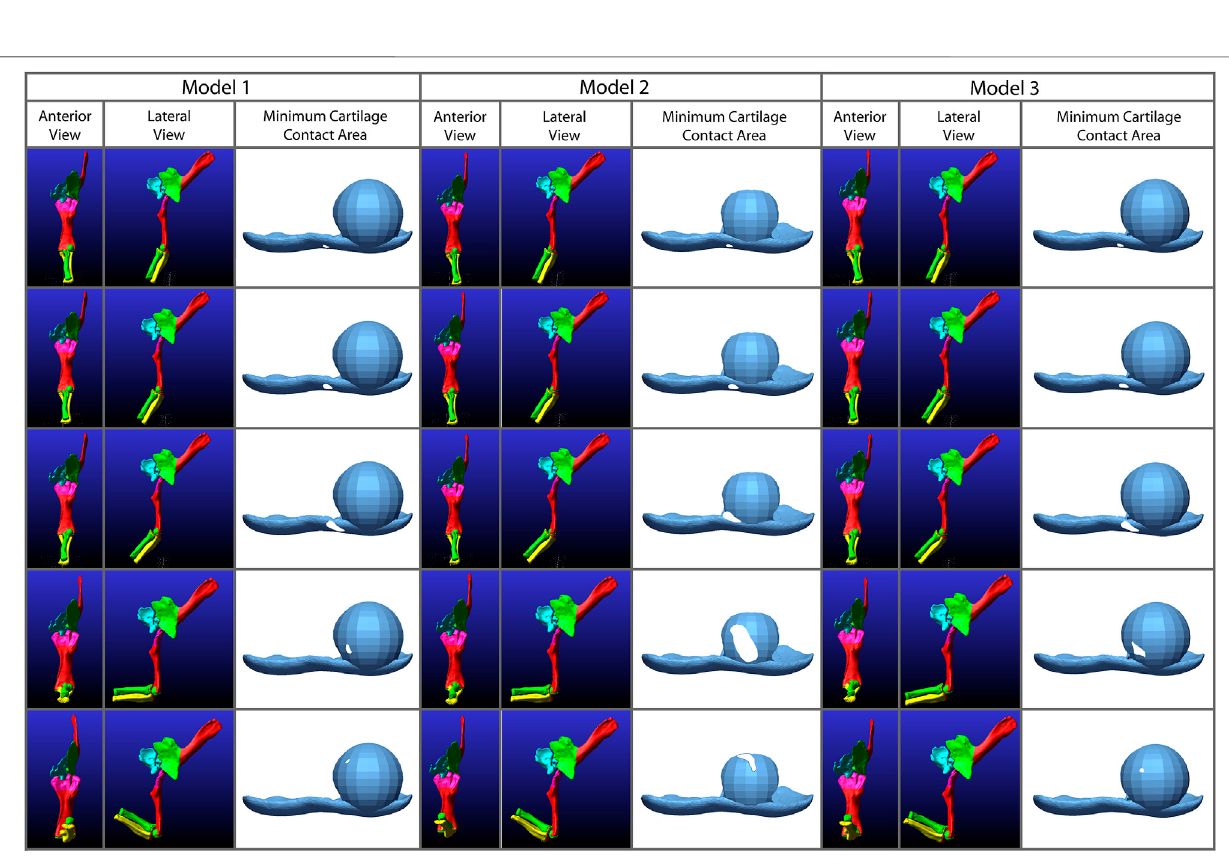
cartilage sphere, at which point all three models diverge. In general, our third model exhibits the largest area of contact between the radial and humeral articular cartilages at all